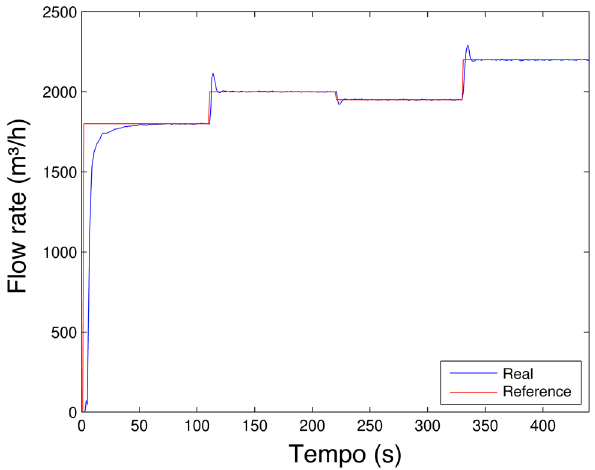
21. Flow rate control experiment Scenario 3.